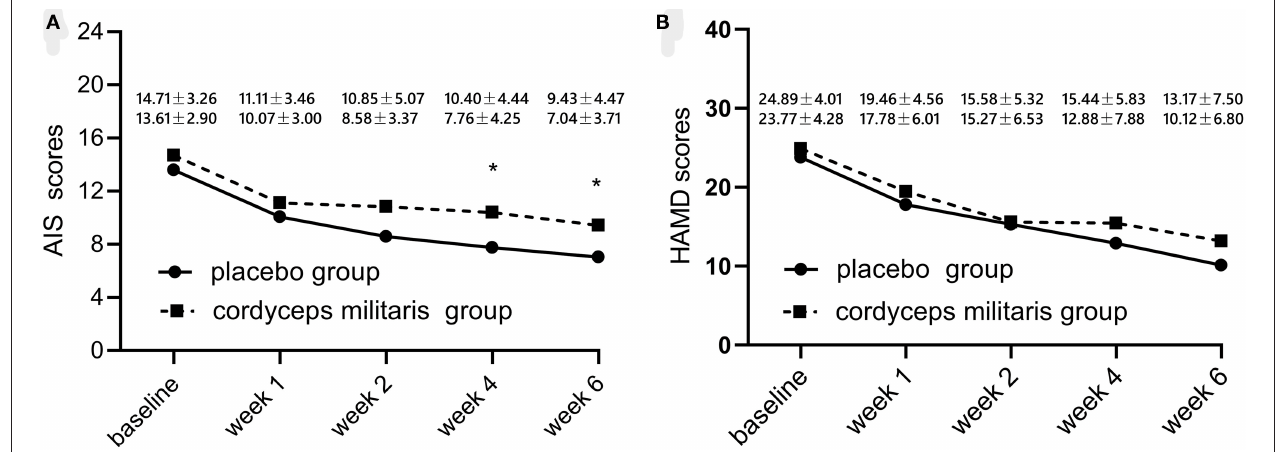
FIGURE 2 | Changes in sleep quality (A) and HAMD score (B) with treatment from baseline to 6 weeks after treatment initiation. The placebo group is represented by the dotted line and the C. militaris group is represented by the solid line. * p < 0.05.